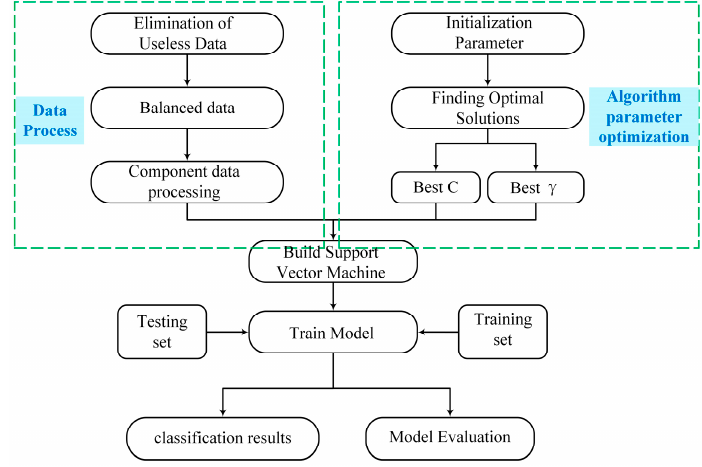
Figure 1. Experimental Process.